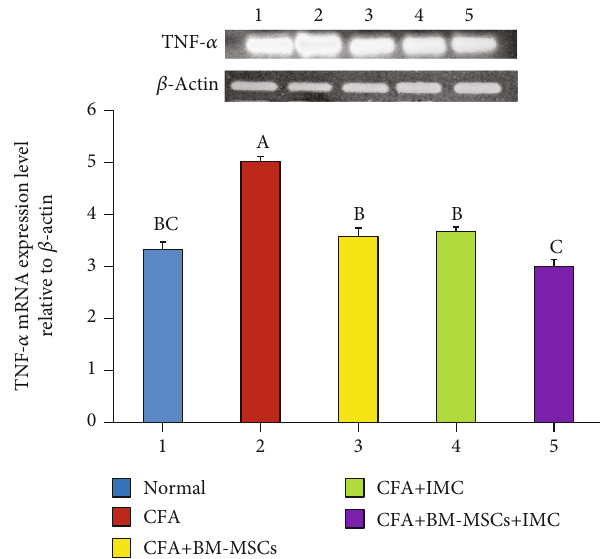
Figure 5: E ff ect of BM-MSCs and/or IMC on the TNF- α expression level relative to β -actin in CFA-induced rats. Means, which have di ff erent symbols, A, B, and C, are signi fi cantly di ff erent at p < 0 : 05